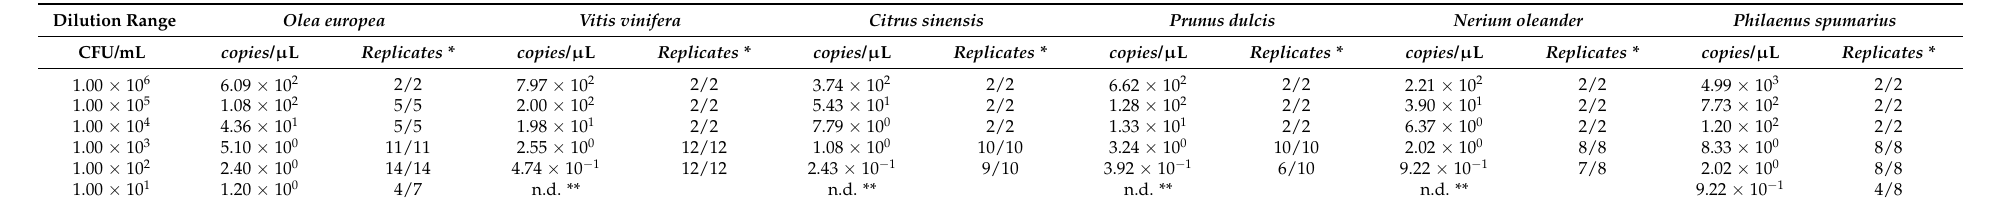
Table 3. Mean concentrations were estimated in copies/ µ L, as measured by ddPCR in each serial dilution of the spiked plant and insect